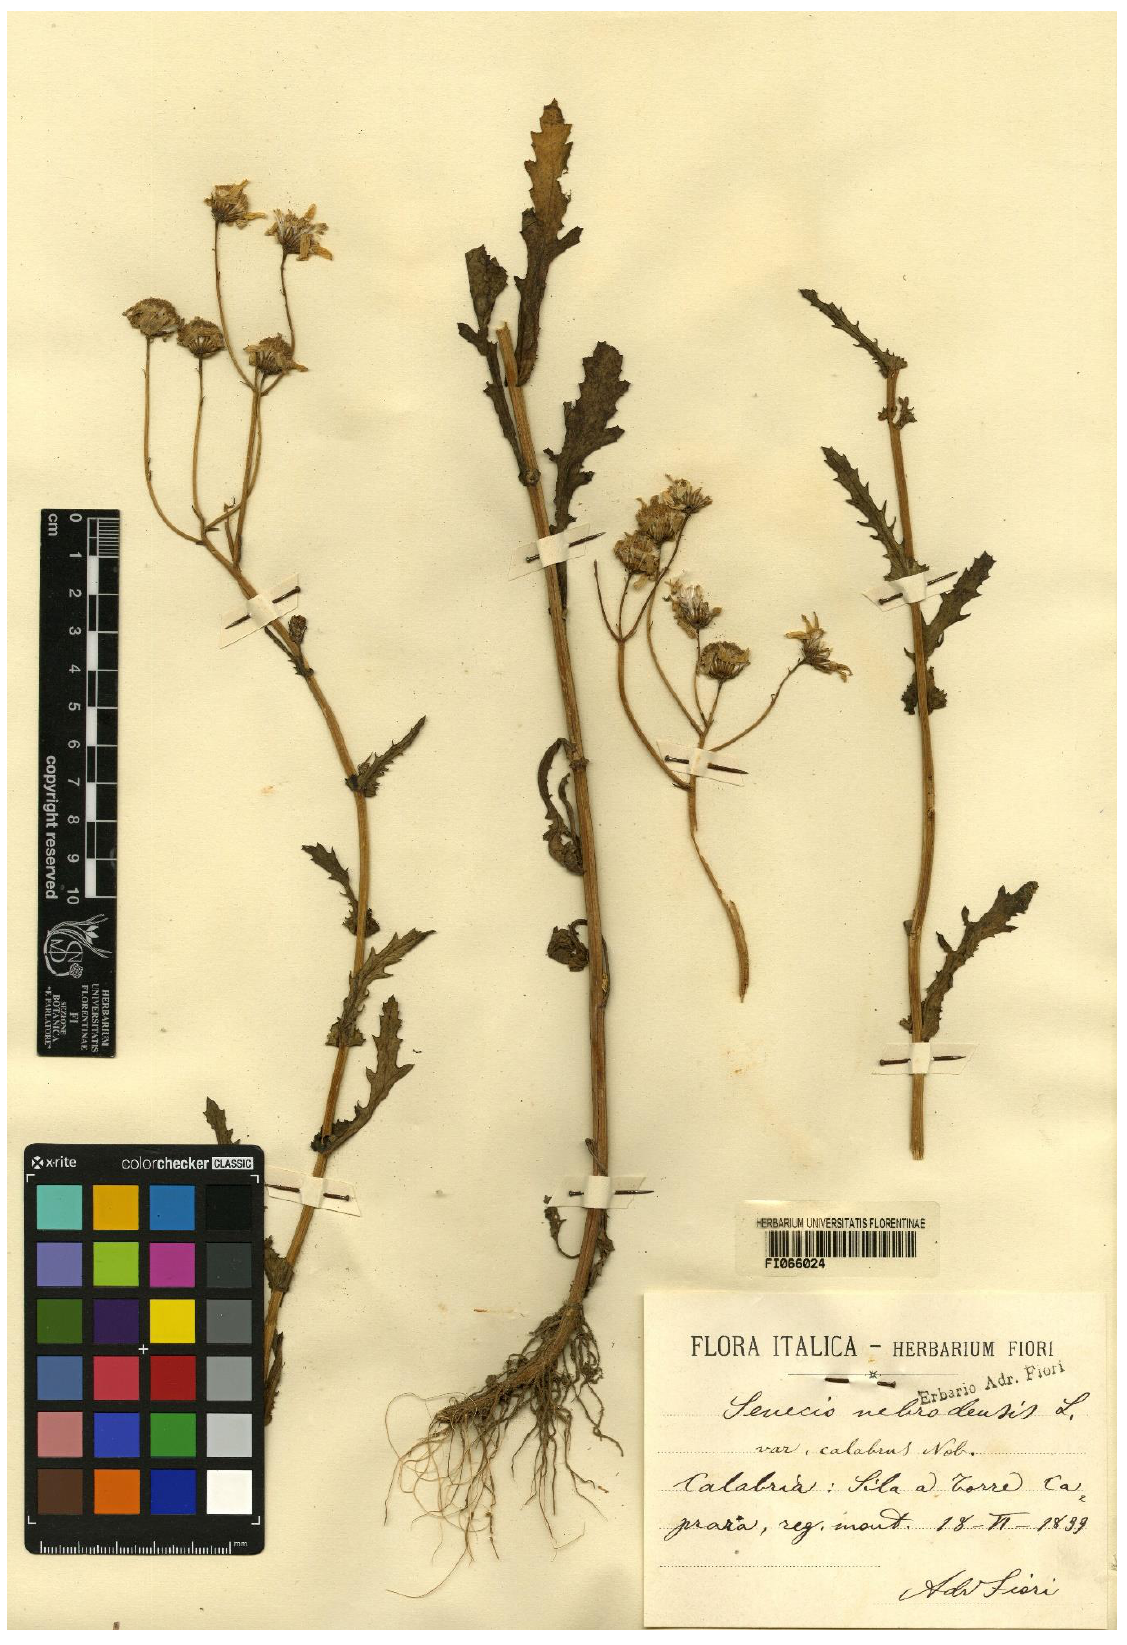
Figure 5. The specimen FI066024 collected by Adriano Fiori and here designated as lectotype of the name Senecio nebrodensis var. calabrus Fiori (photo reproduced with permission).